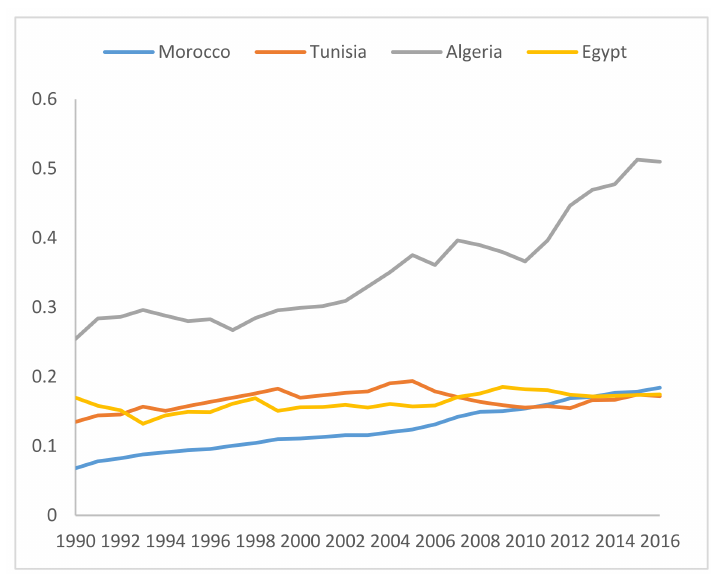
Figure 1. Residential CO 2 emissions in the four North African